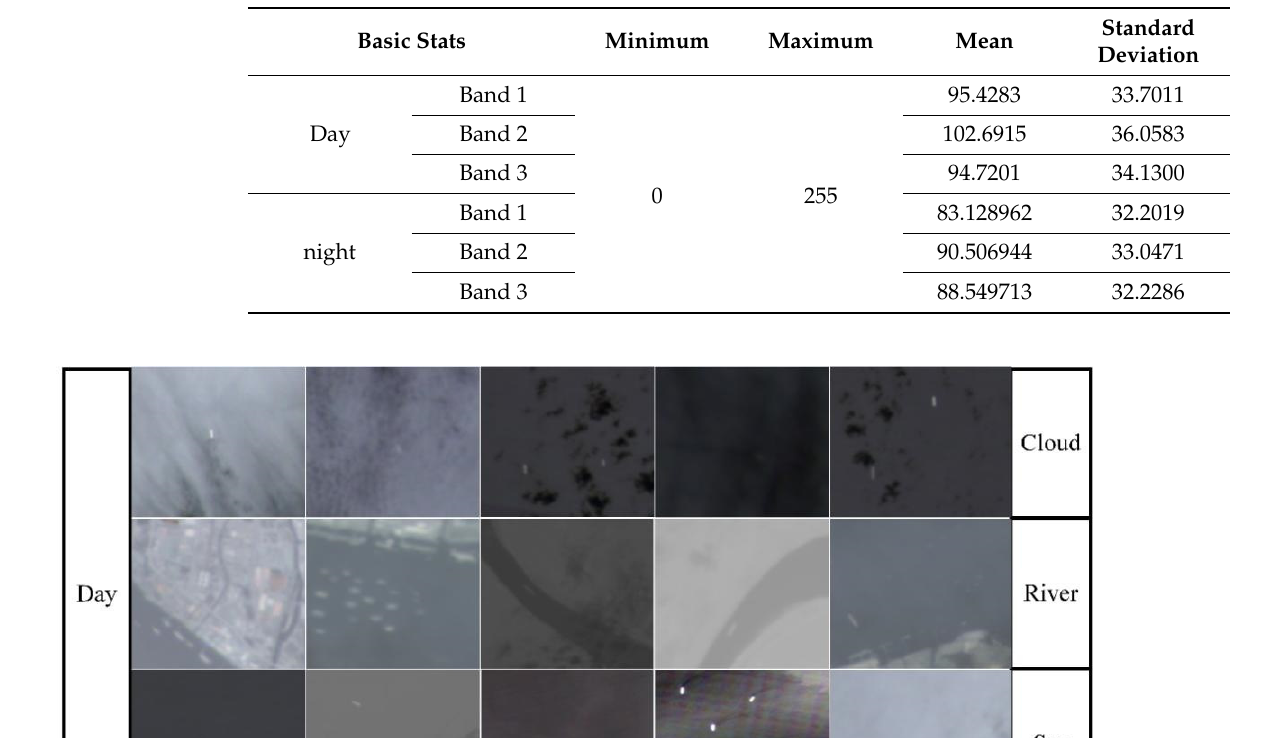
10 of 22 Figure 5. Statistical results of ( a ) aspect ratio of ship target bounding box and ( b ) the brightness temperature on the pupil (T/K) between the ships and sea surface in 8~10.5 µm in the TISD. 3.4. Dataset Feature Analysis